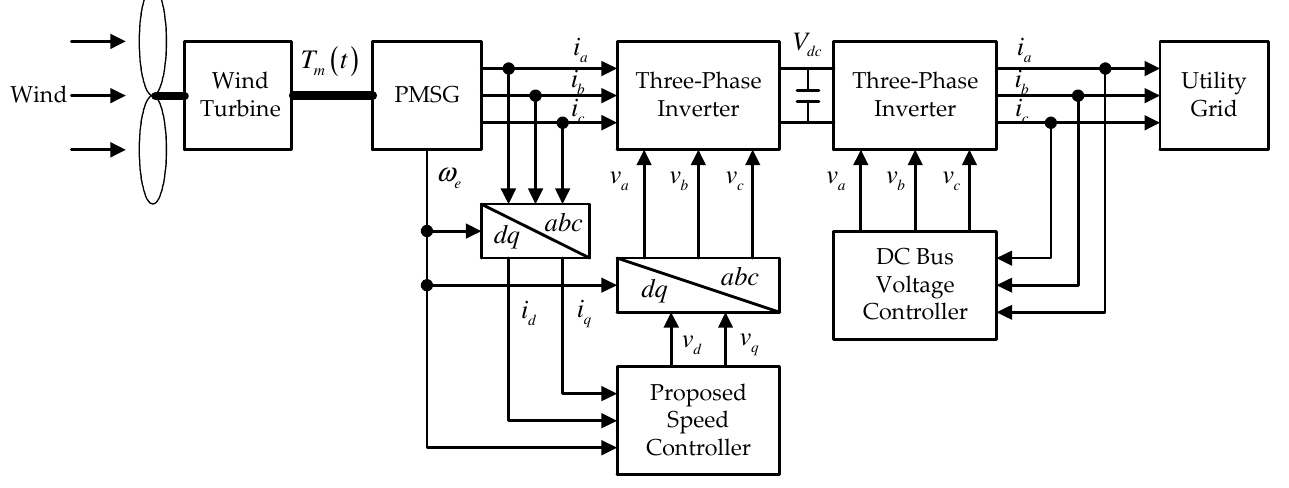
Figure 1. Simulated closed-loop system.